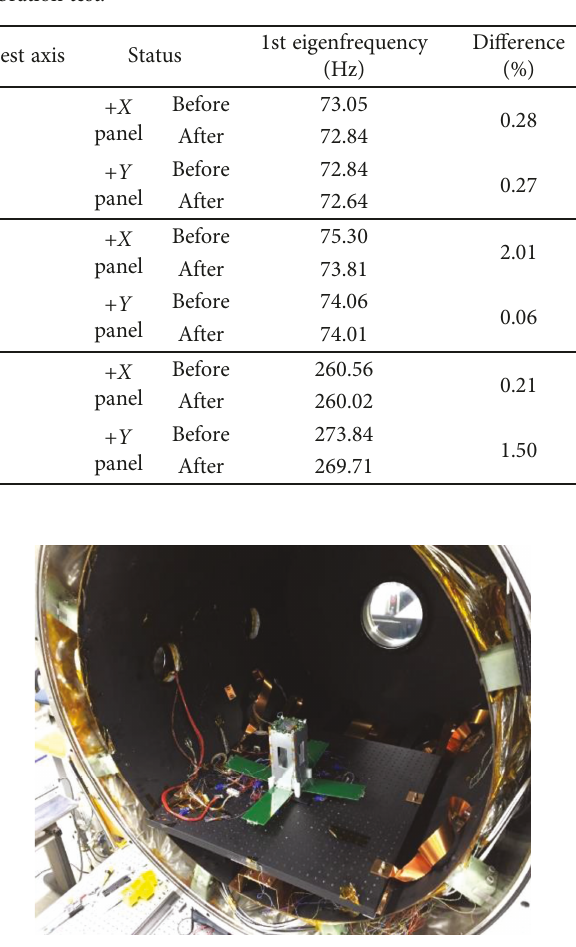
Table 3: Representative LLSS test results before and after each vibration test.